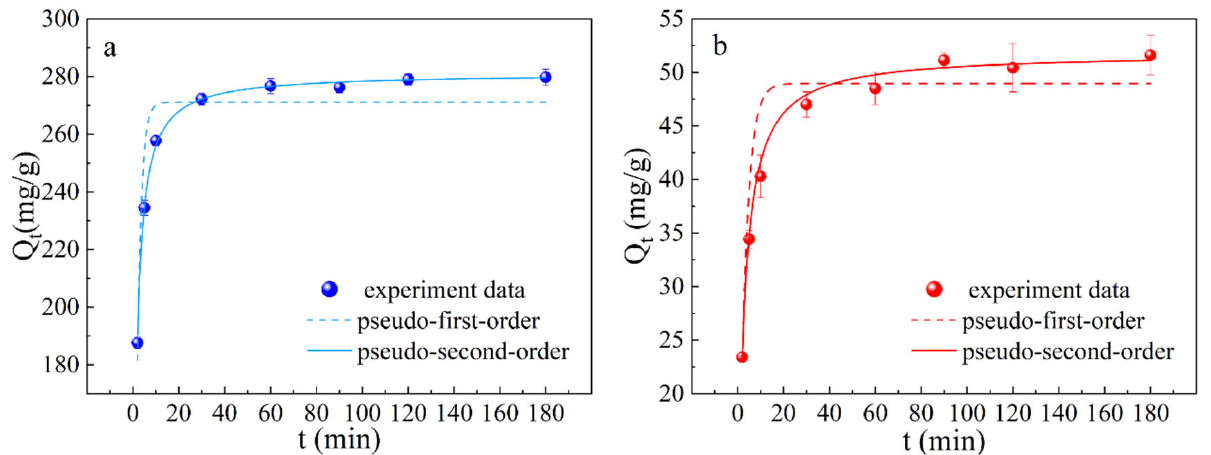
Figure 8. Non ‐ linear fitting of pseudo ‐ 1st ‐ order and pseudo ‐ 2nd ‐ order for ( a ) Pb(II) and ( b ) Cu(II) Figure 8. Non-linear fitting of pseudo-1st-order and pseudo-2nd-order for ( a ) Pb(II) and ( b ) Cu(II) adsorption by ZMA. adsorption by